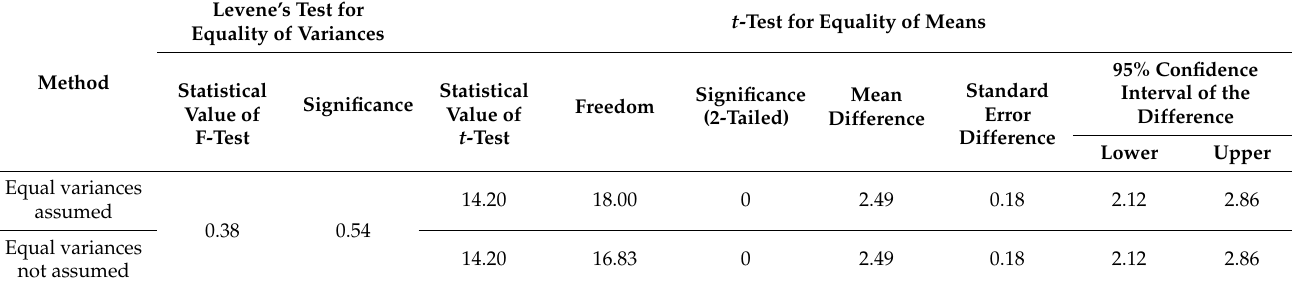
Table 5. t -Test result of discoloration chromaticity